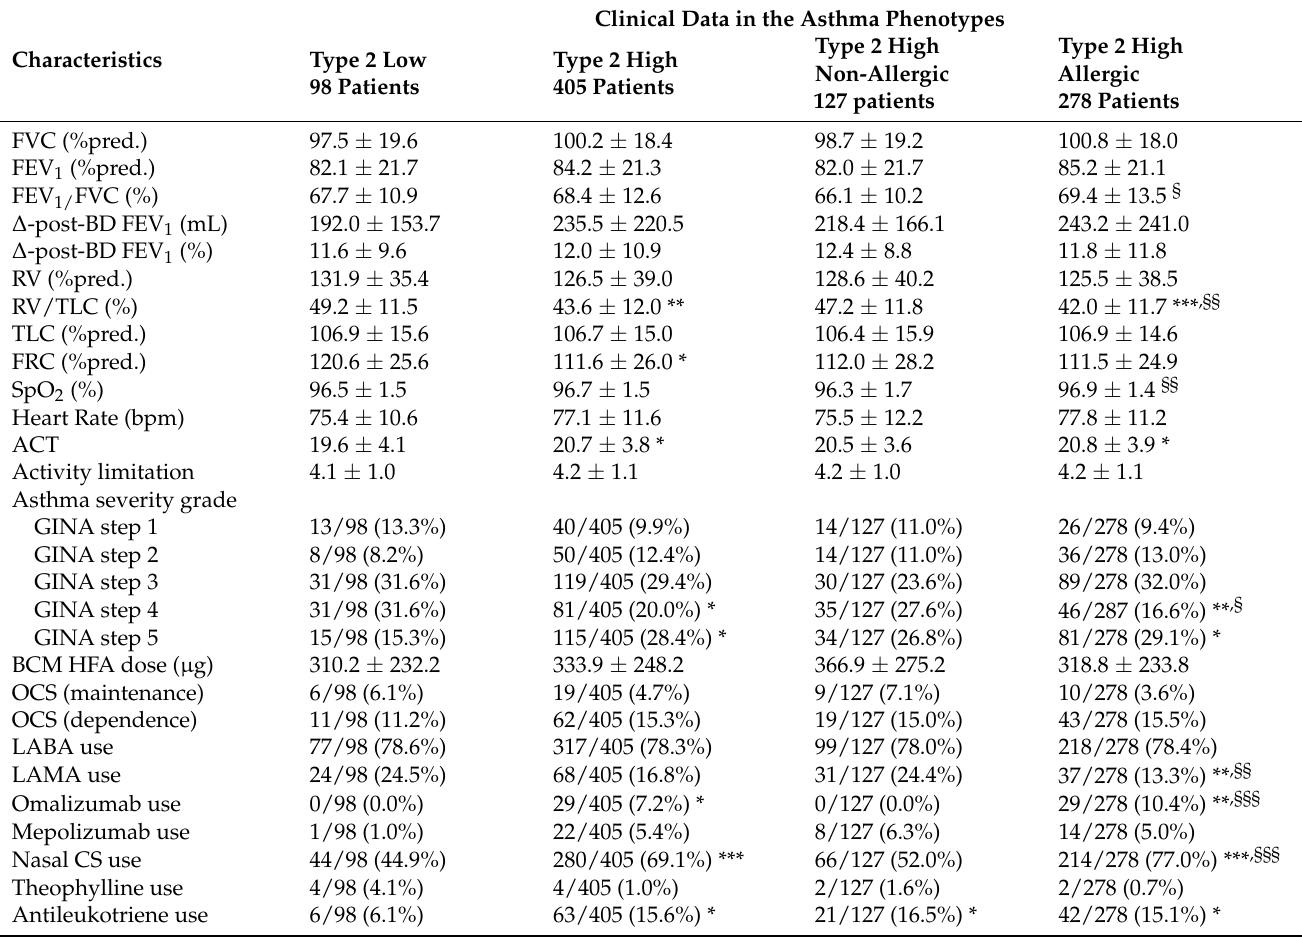
Table 4. Lung Function and therapeutic strategies of patients ( n = 503) stratified according to asthma phenotypes. The results are expressed as mean with standard deviation or as the number of subjects with